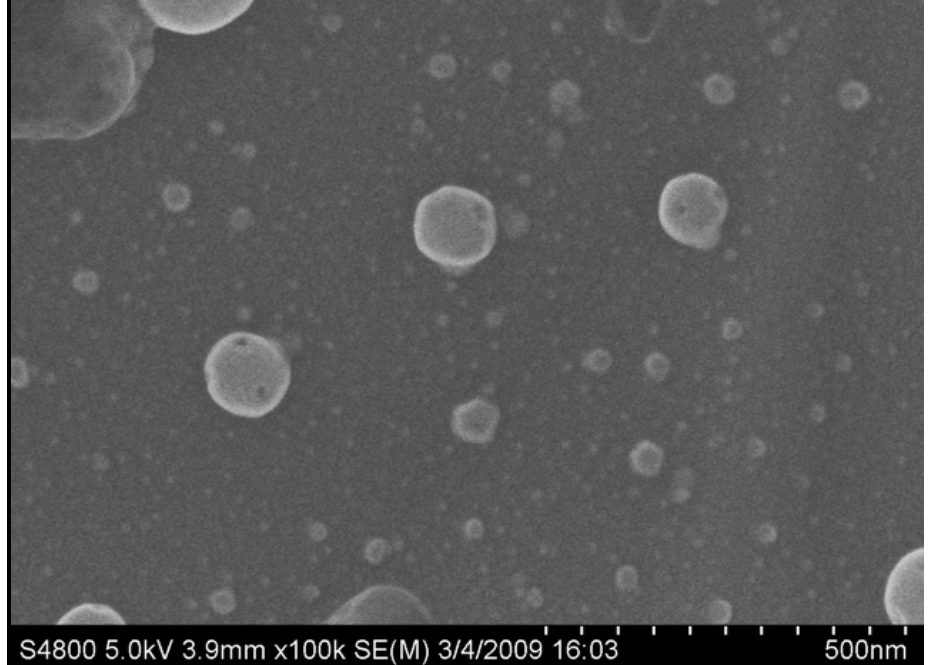
Figure 2. The SEM images of the Fe